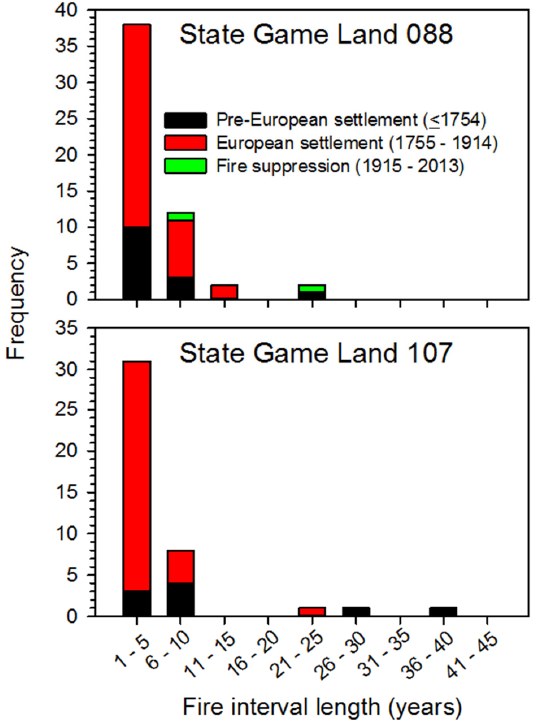
Figure 6. Frequency distributions of fire intervals at SGL 088 and SGL 107 color coded by time period.